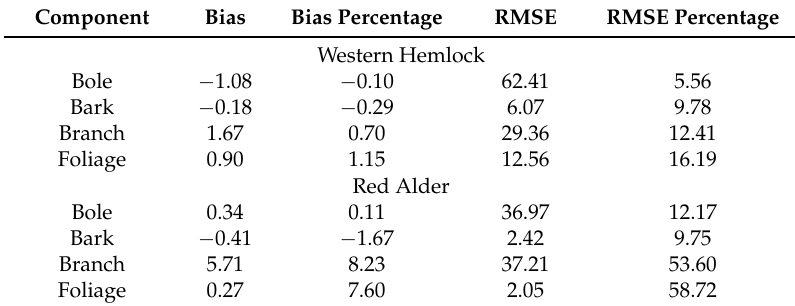
Table 6. Evaluation statistics (Bias, bias percent, RMSE, and RMSE percent) in component biomass estimation in Western hemlock and red alder trees using beta regression.